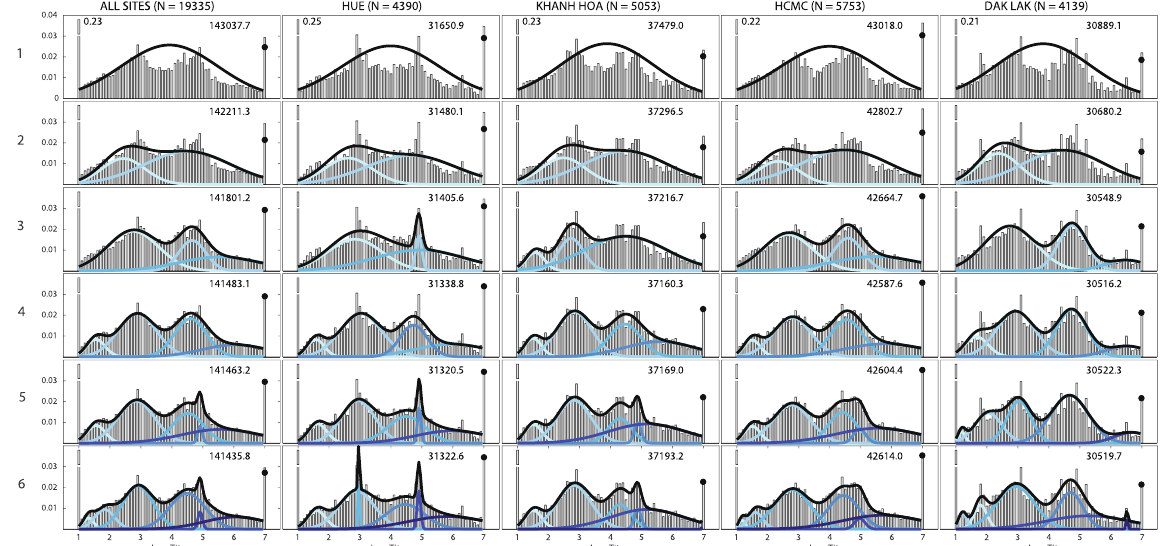
Figure 2. Titer histograms for 2009 H1N1, showing fit results for mixture models with different numbers of normal components (top to bottom; the label to the left of the y ‐axis is the number of mixture components) and grouped by collection sites. Histograms are weighted to adjust for age and gender according to the Vietnam national housing census in 2009 for each of the four collection sites. The blue lines in each panel are the normalized probability density functions of the component distributions with darker colors used for increasing μ . The black lines show the full mixture distribution density, and the black dots are the estimated cumulative distribution of the mixture models at 7.0 (titer of 1280). The numbers in the upper right corner of each panel are the BIC scores of the model fits. The fractions of individuals with titers below the detection limit of 20 and above 1280 that were out of the plotting ranges were given next to their respective bars.